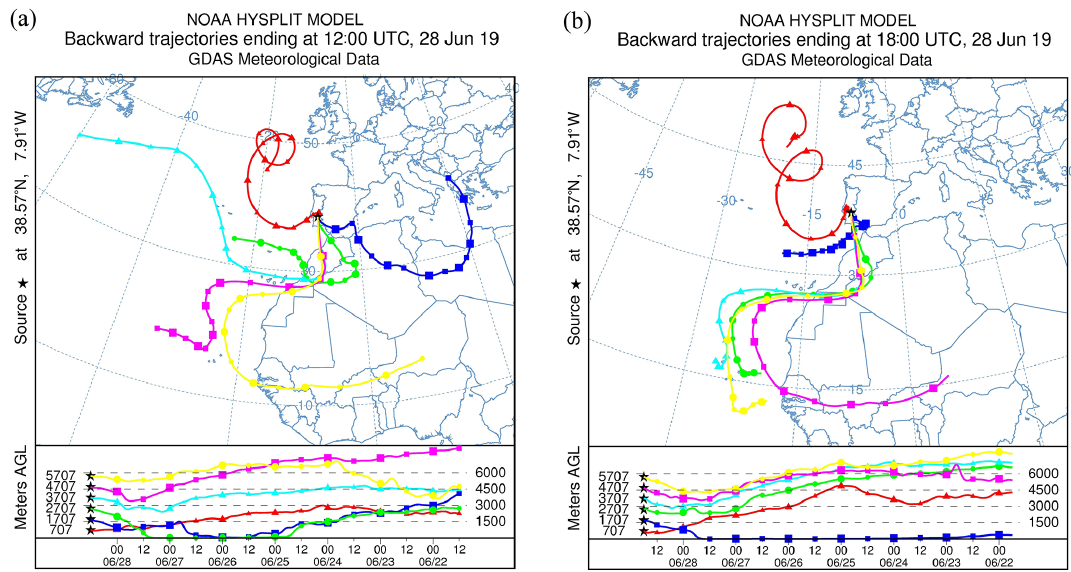
Figure 7. HYSPLIT model back trajectories for the air masses over Évora between 0.7 and 5.7kma.g.l. (equivalent to 1 and 6kma.s.l., respectively) on 28 June 2019 at (a) 12:00UTC and (b)